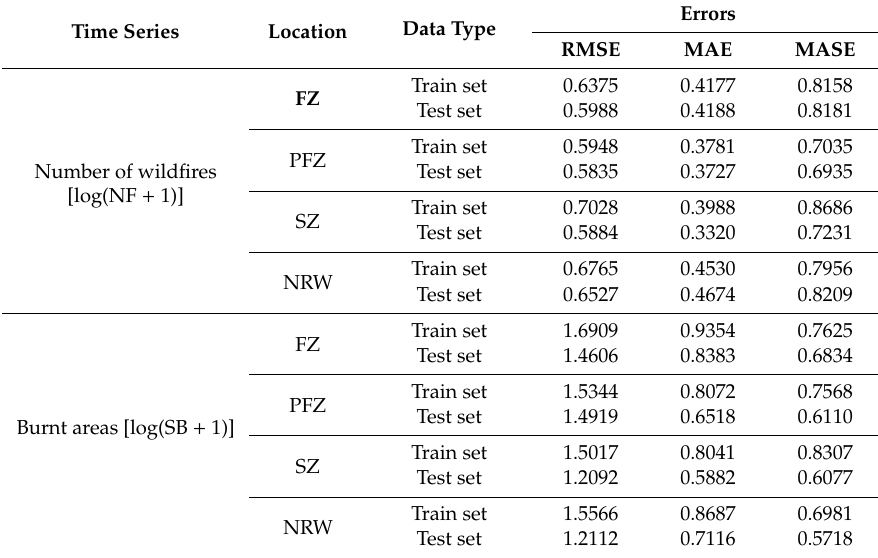
Figure 6. Forecasts of the total burnt areas in the (a) forest zone, (b) pre-forest zone, (c) Sudanian zone, and (d) whole NRW using the training dataset. Figure 5; Figure 6 show the forecasts of ARIMA applied to the monthly number of wildfire occurrences and the total burnt area estimation, respectively, using data only up to the end of 2016. The results showed that the actual values matched the predicted values at a 95% confidence level. For determining the prediction models, the testing and training RMSE values of each ecoregion were computed. Table 4 shows the testing and training forecast error values of wildfire activity in each ecoregion. RMSE values ranged from 0.5 to 1.7, while MAE values varied between 0.3 and 1.0, which presages a good quality of the models. The testing RMSE values were lower than training RMSE values and showed the good performance of the fitted models. Table 4. Cross-validation of the fitted models of wildfire time series by ecoregion.